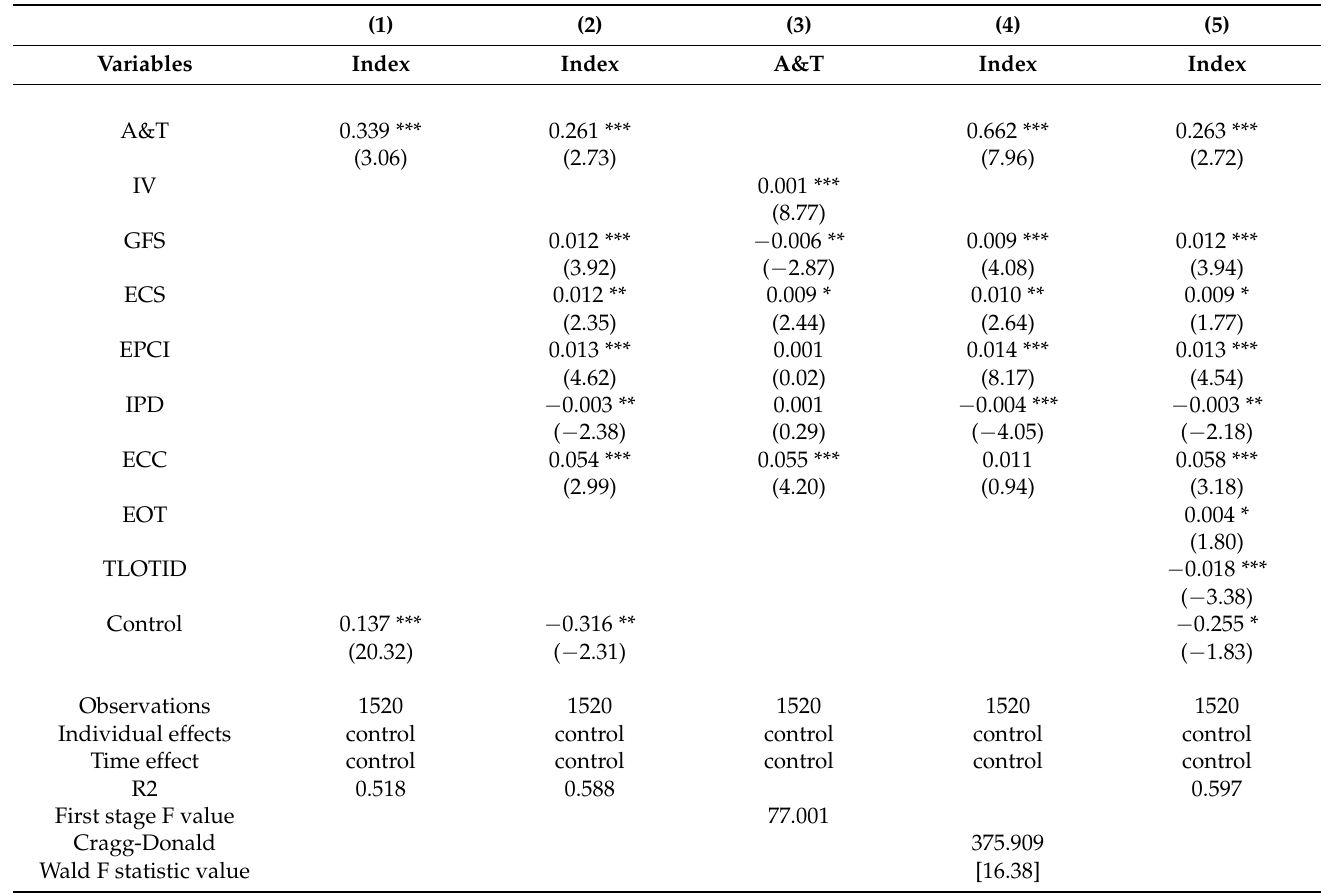
Table 3. Benchmark regression, endogeneity test, and robustness test